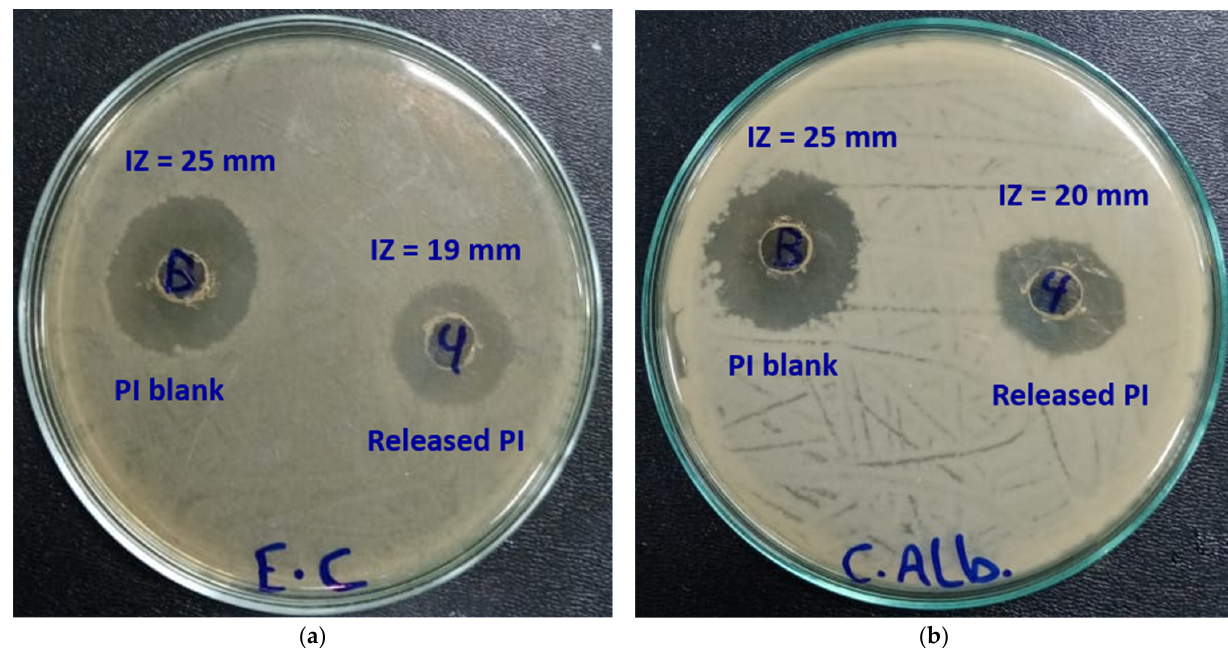
Figure 10. Biological activities of PI (left) and released PI (right) against; ( a ) E. Coli and ( b ) C. Albicans.